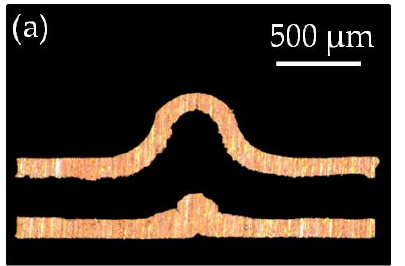
Figure 11. Axial cross ‐ section of T ‐ shape samples (C1220) under different MTHF conditions: ( a ) sample hydroformed at p h = 50 MPa, Δ L = 450 μ m; ( b ) sample hydroformed at p h = 120 MPa, Δ L = 700 μ m.